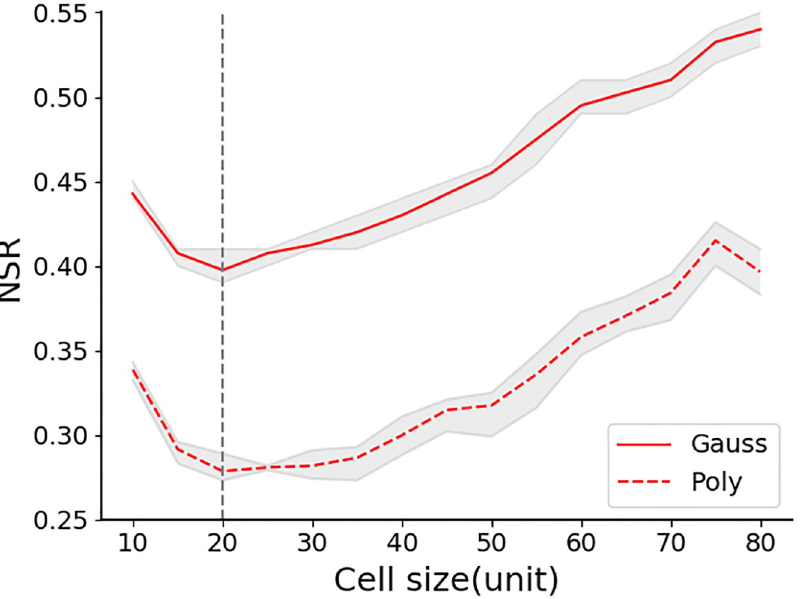
Fig 8. Influence of different fitting models on the NSR. Data used are single-centered data in the ‘experiments with synthetic data’ section where N = 10,000, σ = 150. The solid and dashed lines represent results fitted by the Gauss and polynomial models,